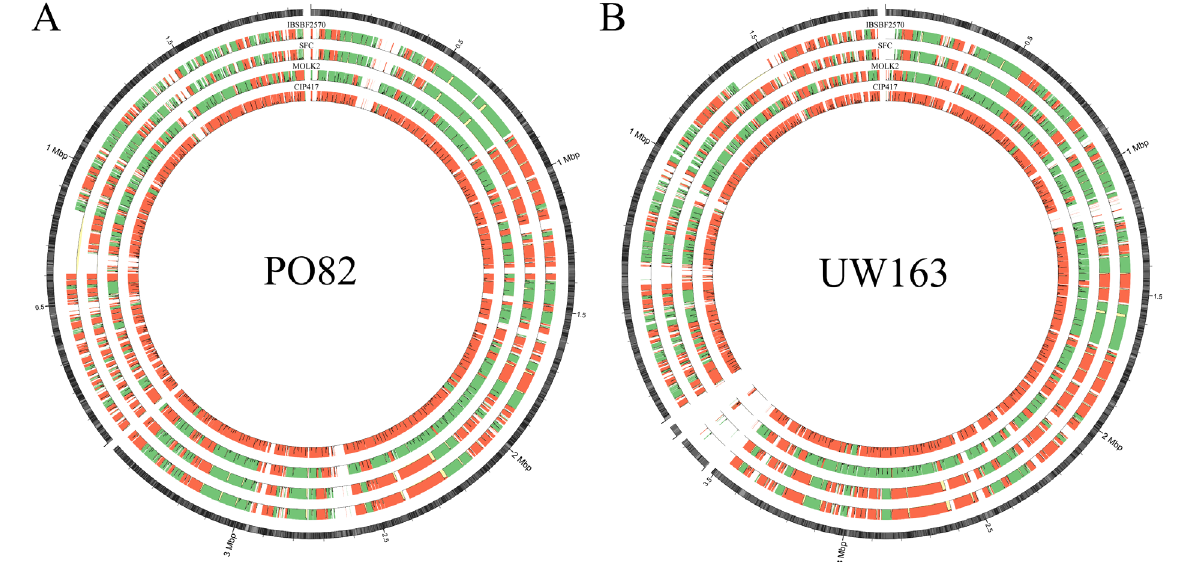
Figure 2 – Visualization of the alignment of Ralstonia solanacearum isolates causing Sergipe facies (SFC and IBSBF2570) and Bugtok disease (CIP417 and Molk2) with the reference isolates Po82 (A) and UW163 (B) of R. solanacearum . The outer circle represents the reference sequence with GC (%) heatmap [from 0% (white) to 77% (black)]. Assembly tracks are combined with the display of incompatibilities: taller columns indicate a higher rate of incompatibility. Darker colors indicate higher gene density. The green color represents similar contigs to the reference and red color indicates misassembled contigs.